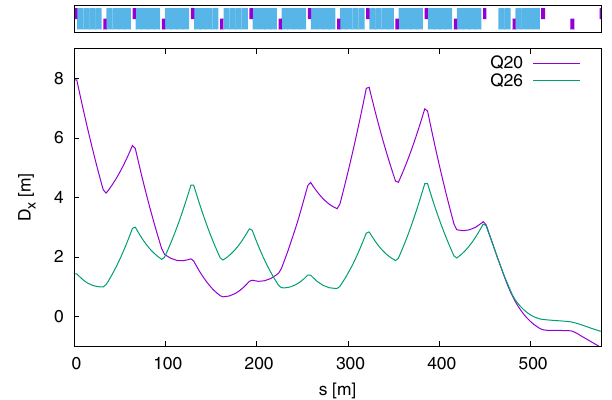
FIG. 1. Horizontal dispersion function for Q20 and Q26 optics. Thanks to the sixfold periodicity of the SPS [1], the horizontal axis includes only half of an arc followed by half of an LSS. The machine layout, comprising dipoles (blue) and quadrupoles (purple), is given in the top panel.